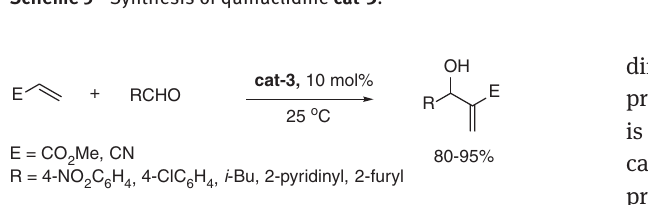
Scheme 5 Synthesis of quinuclidine cat-3 .